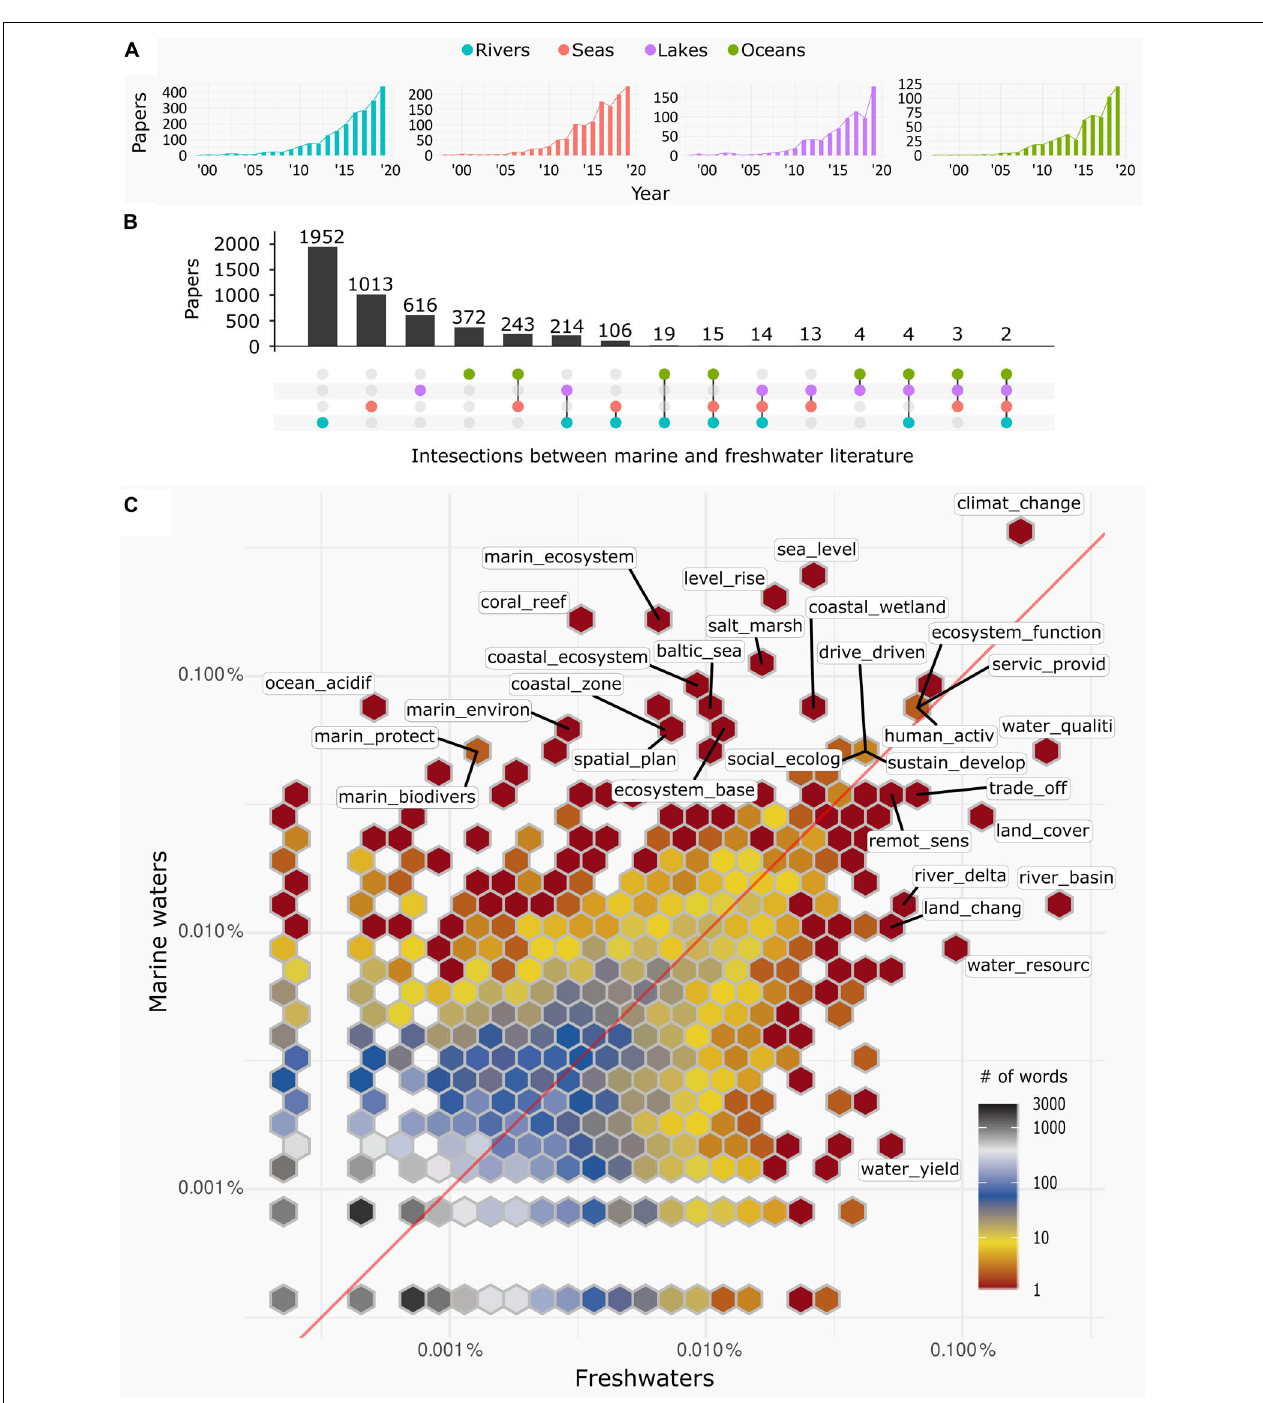
FIGURE 1 | Correlation of aquatic systems based on sharing of ecosystem services (ES) concepts. (A) Publication trend of aquatic-ES papers (1997–2020). (B) upSet plot displaying the repartition of papers among and within systems. Bars are paper partitions; histograms display the size of the partition. Colours in (B) are as in (A) . (C) Comparison of word frequencies between fresh- and marine waters. The plot is a 2d histogram with hexagonal bins, marking 2d range in frequencies; histogram colour represents the number of words with that 2d range; no hexagon is drawn in areas without points. The closer a hexagon is to the red line, the more the words within it are used with similar frequencies and the other way round. Words with a frequency higher than 0.0005% are explicitly shown as labels in each plot, with lines connecting each word to its bin. The x and y scales are in logs and mark the relative bigram frequency within fresh- and marine waters, respectively.